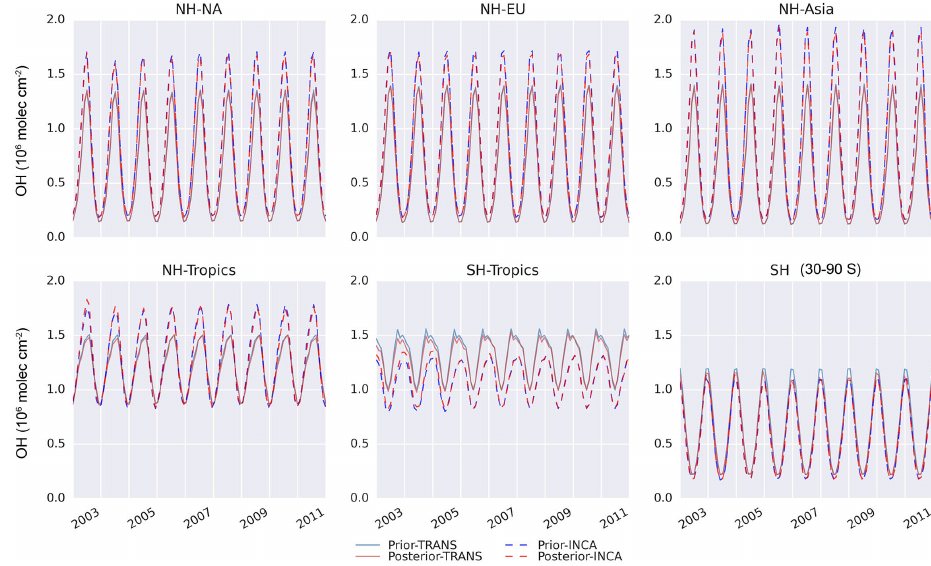
Figure 7. Regional volume-weighted monthly mean OH concentrations in the prior and posterior. The results are shown for the six big regions in which OH is